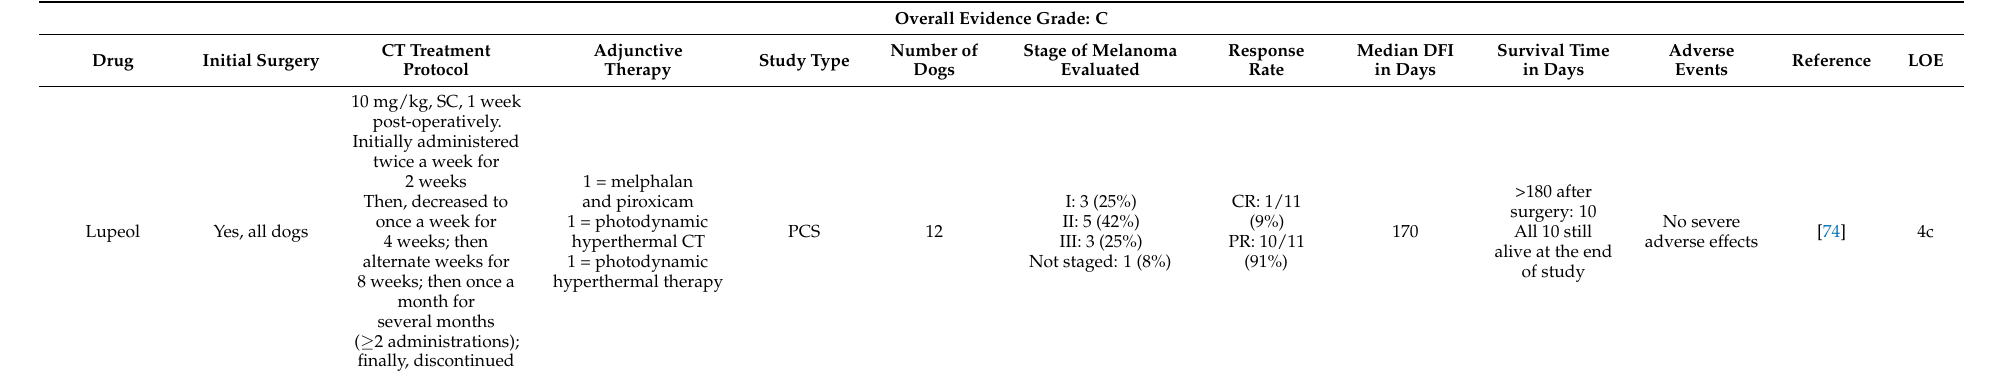
Table 8. Summary of an alternative study evaluating effectivity in oral malignant